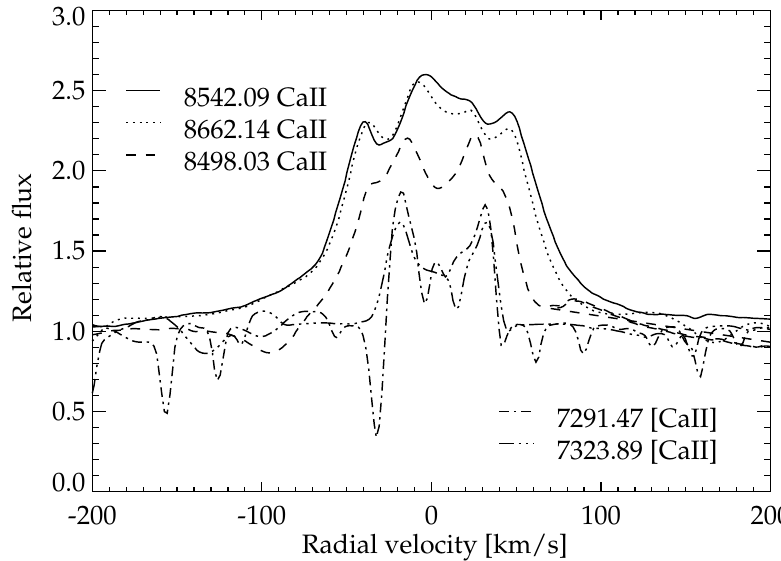
Fig. 6. Here the emission lines of Ca II and [Ca II] are